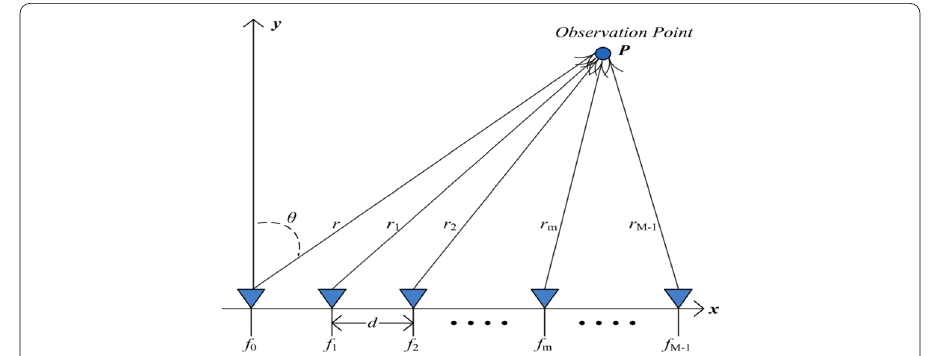
Fig. 4 Uniform linear frequency diverse